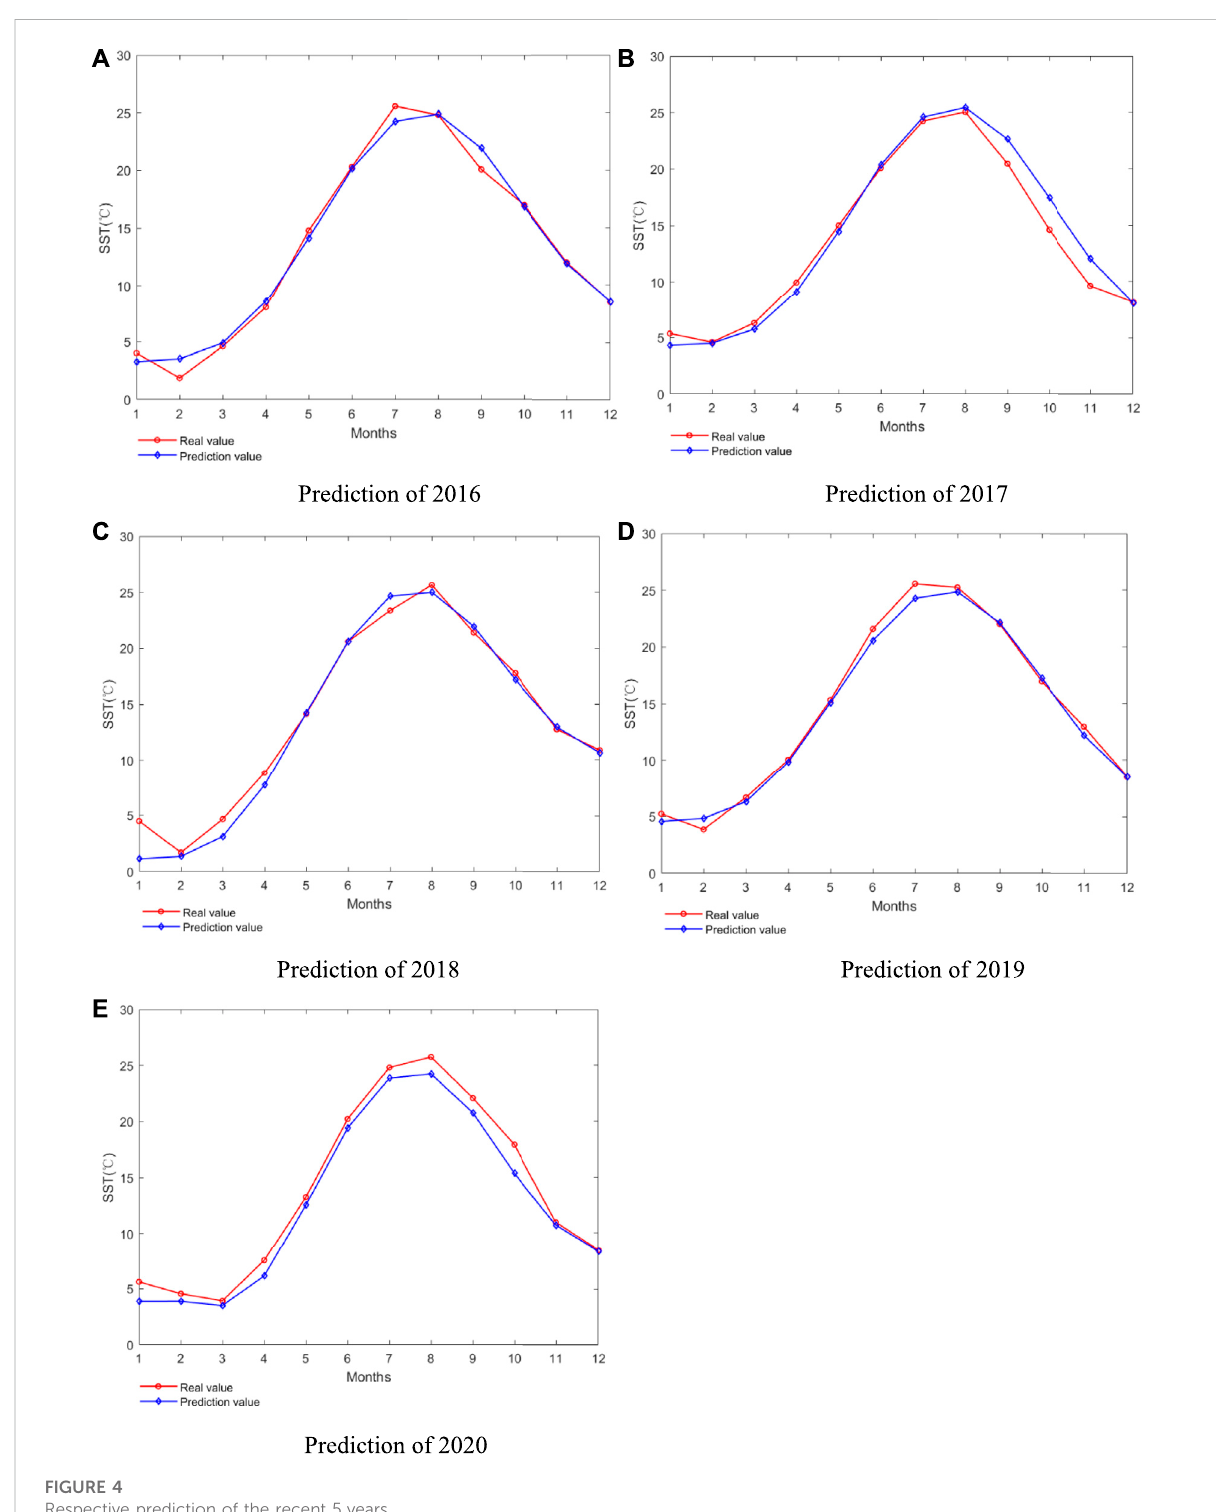
FIGURE 4 Respective prediction of the recent 5